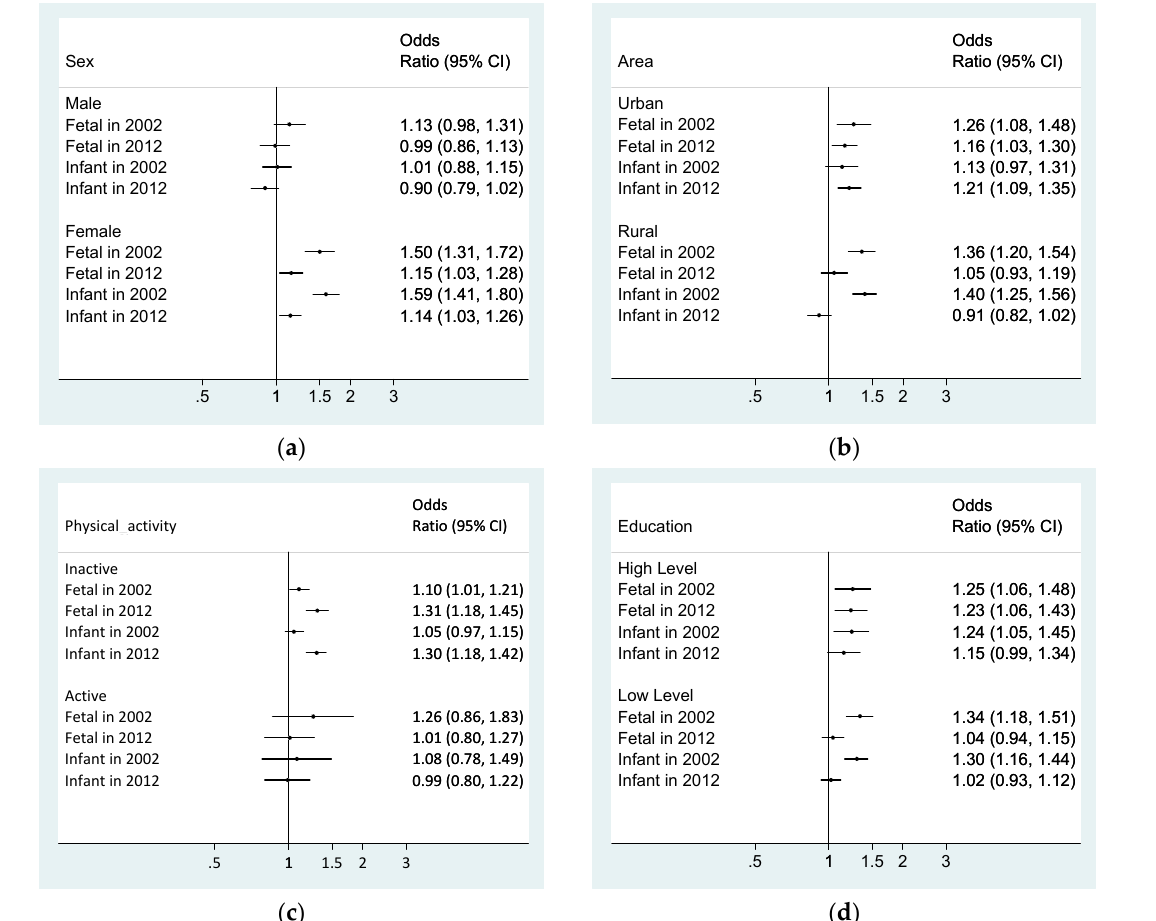
Figure 1. Subgroup analyses of the association between central obesity and famine exposure groups. ( a ) Associations of famine exposure with central obesity risk by sex; ( b ) Associations of famine exposure with central obesity risk by area; ( c ) Associations of famine exposure with central obesity risk by physical activity; ( d ) Associations of famine exposure with central obesity risk by education level. Model adjusted for sex, residential areas, education level, marital status, household income, current drinking status, current smoking status, and physical activity. Stratified variables were not adjusted in the corresponding models. CI, confidence interval. All odds ratios used the nonexposed group as the reference.